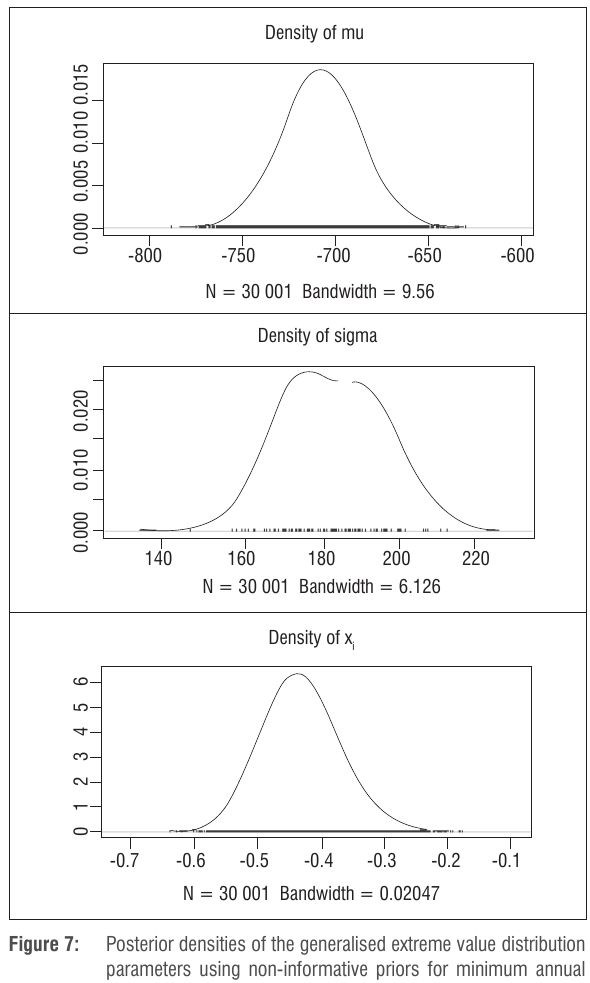
Figure 7: Posterior densities of the generalised extreme value distribution parameters using non-informative priors for minimum annual rainfall for Zimbabwe for the period 1901–2009.